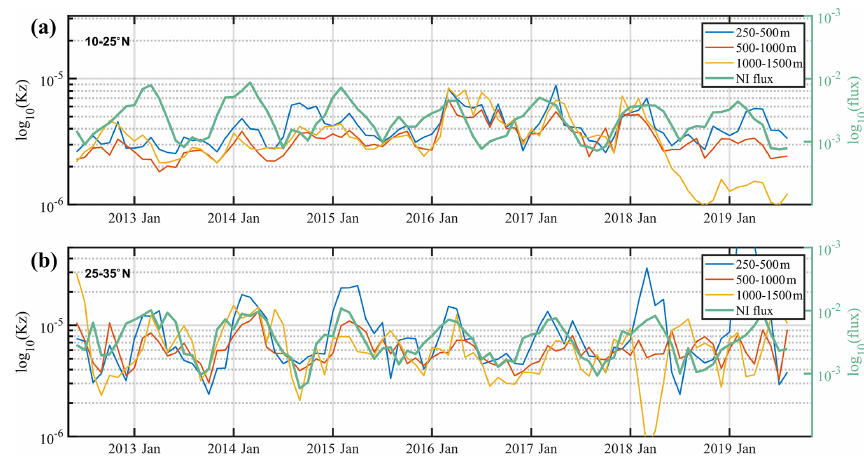
Figure 3. Seasonal cycles in diapycnal diffusivities (colorful lines) and near-inertial energy flux from wind (green) extents at 250–500, 500–1000, and 1000–1500m in (a) 10–25 ◦ N and (b) 25–35 ◦ N, which is averaged in each month and in all water